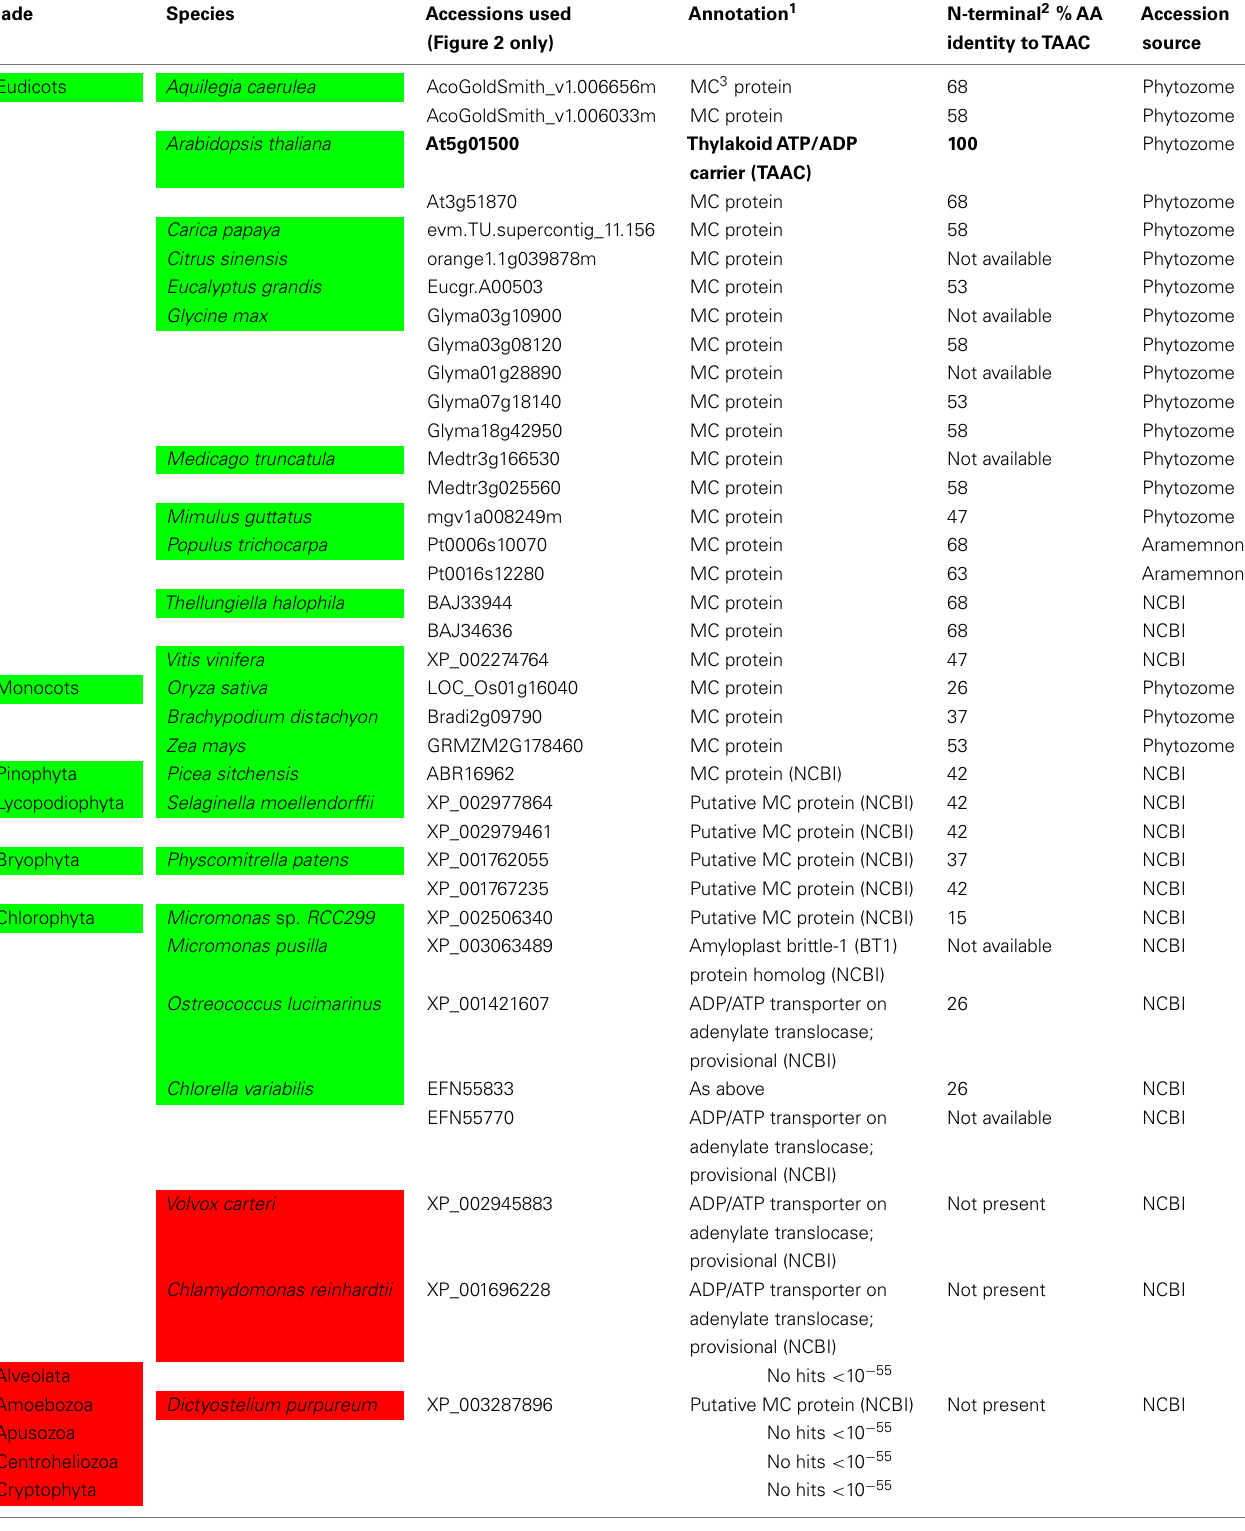
Table 2 |The presence (green) or absence (red) ofTAAC-like proteins within the surveyed genomes is shown.